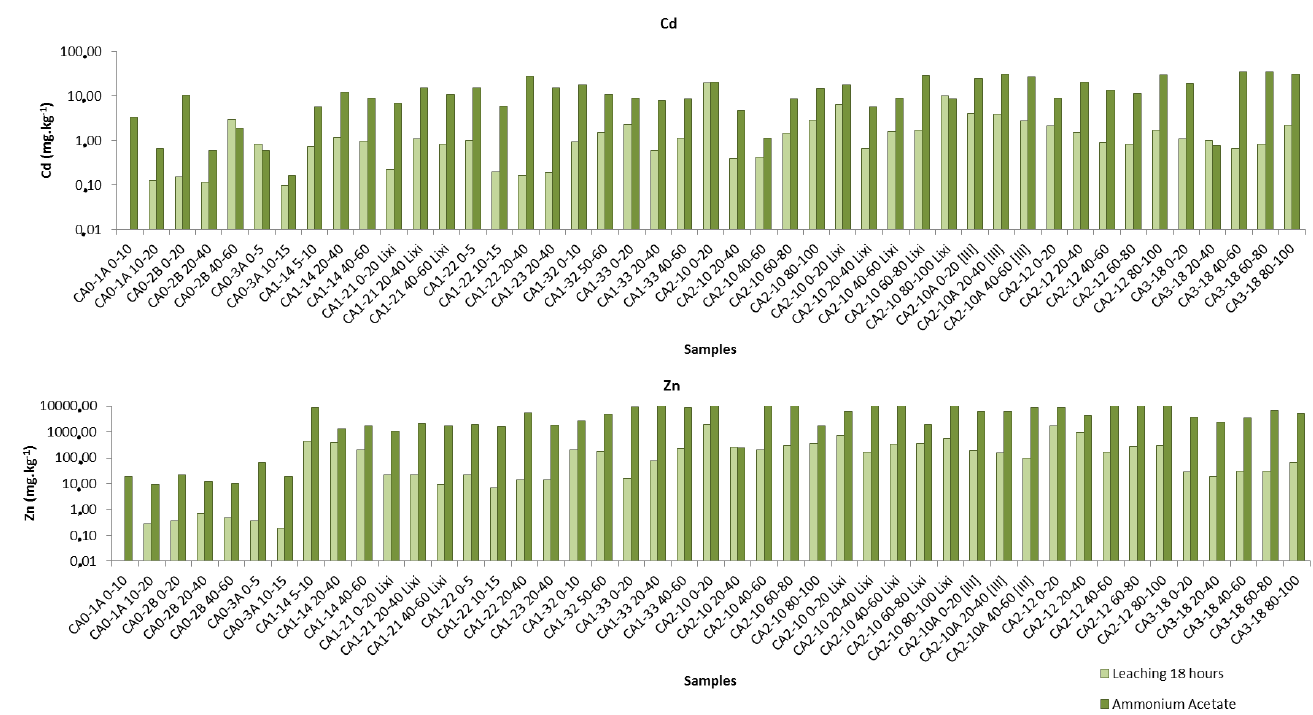
Figure 6. Comparison between leaching values of alluvial sediments by stirring the samples with water for 18 h, and the contents extracted by ammonium acetate, for Cd and Zn; Samples with designation [III] correspond to the post-rain season; graphs in logarithmic scale.